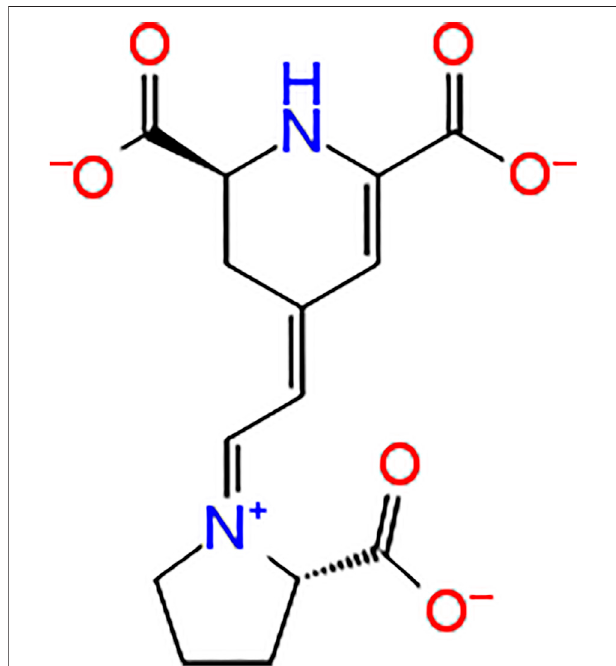
FIGURE 1 | Indicaxanthin